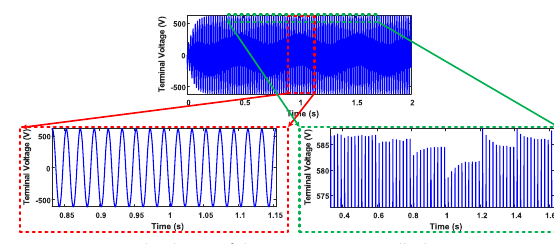
Fig. 19 Terminal voltage of the VOC-PSO controlled inverter (R-Phase) with changing the load from 25 to 200%